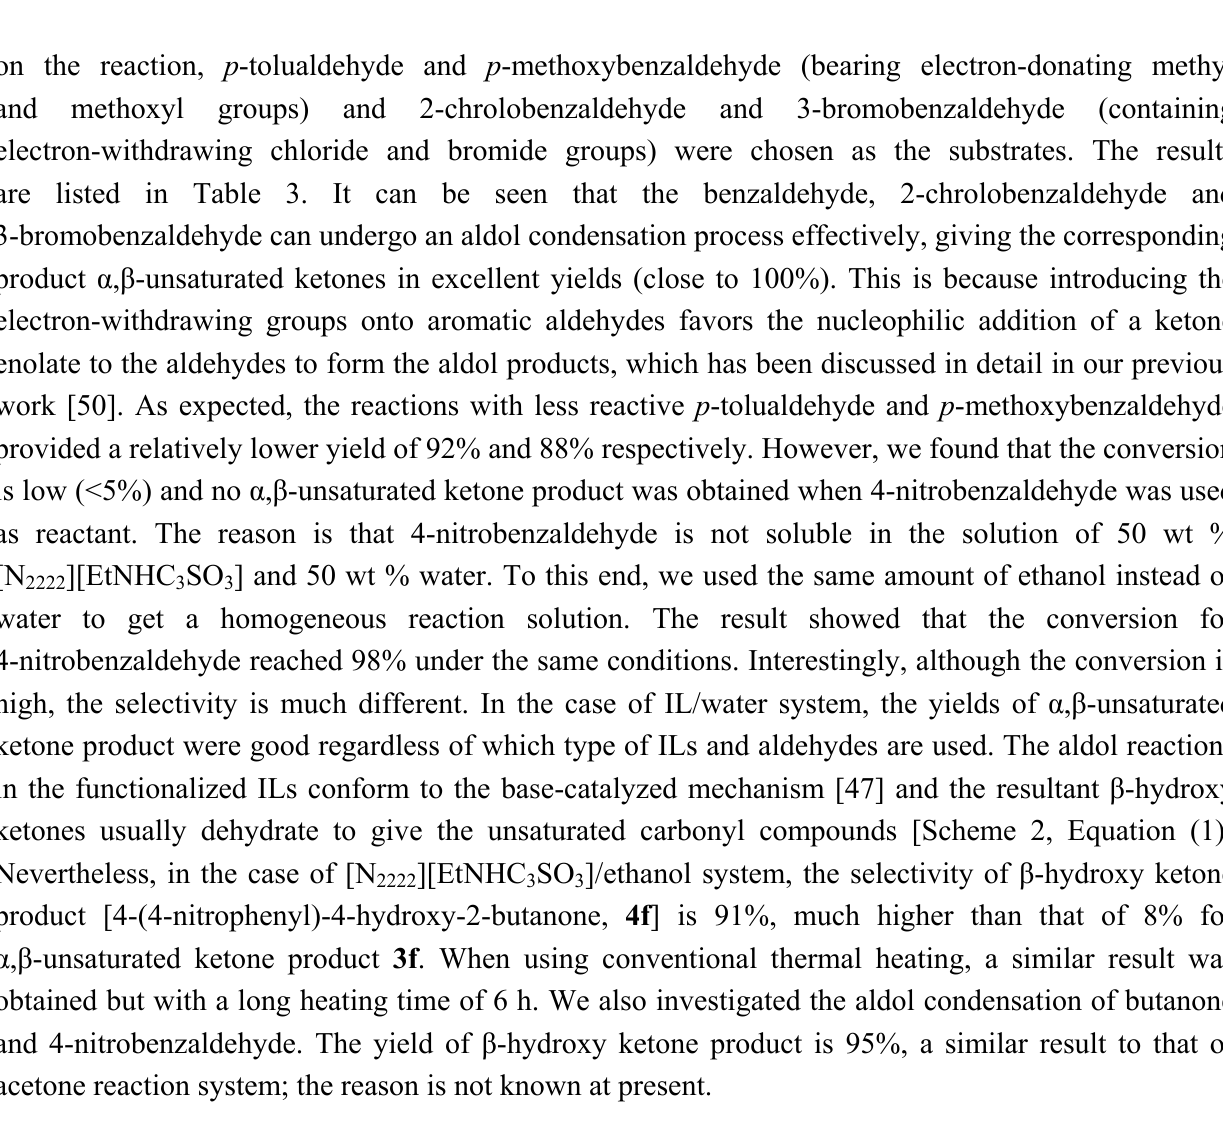
Table 3. Aldol reactions of various aromatic aldehydes with acetone in the ][EtNHC SO ] catalytic systems. Reaction conditions: 3.4 mmol ILs (1.0 g), 50 wt % [N 2222 3 3 of H O (1.0 mL) of catalytic system, 2.5 mmol aromatic aldehydes, 7.5 mmol 2